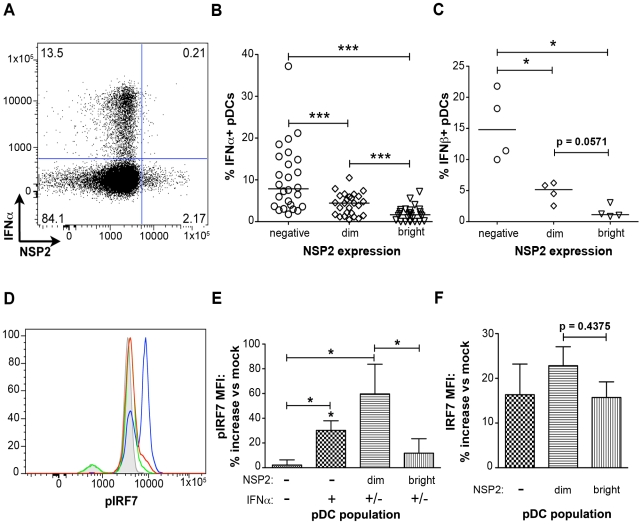
The effect of viral replication on IFNα induction and IRF7 phosphorylation.(A) Representative FACS plot of IFNα vs. NSP2 expression in pDCs stimulated with RRV 6hpi (moi 10). (B, C) pDCs from multiple donors were exposed to RRV and the percent of IFNα+ (B) (n = 26) or IFNβ+ (C) (n = 4) pDCs negative, dim or bright for NSP2 were determined. *:p = 0.0286, ***: p≤0.0006; Wilcoxon signed rank test. Donors with fewer than 0.5% of pDCs staining positive for NSP2 were excluded from this analysis. (D) Representative histograms of IRF7 phosphorylation in NSP2bright (red), NSP2dim (blue), and NSP2- (green) pDCs 6 hours post RRV or mock (gray) stimulus. (E, F) Percent increase in pIRF7 (E) or total IRF7 (F) MFI by indicated pDC populations relative to mock treated pDCs from multiple donors (n = 6), 6 hours post RRV inoculation. *: p = 0.0313; Wilcoxon signed rank test.